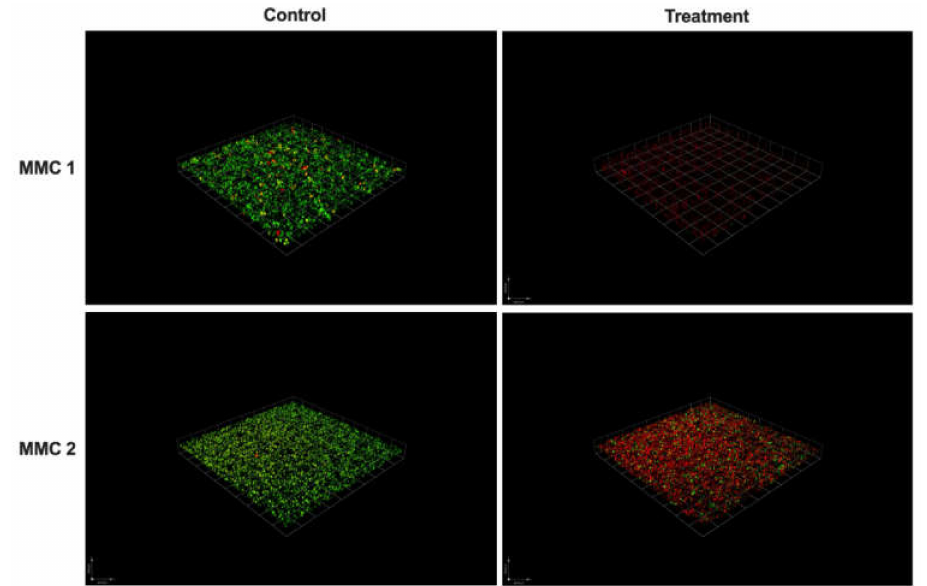
Figure 6. C. auris biofilms grown for 48 h and treated with 500 µL of NAC-SNO-np (10 mg/mL) for 24 h. C. auris biofilm stained with FungaLight (live: green; dead: red). Scale bar represents 100 µm.